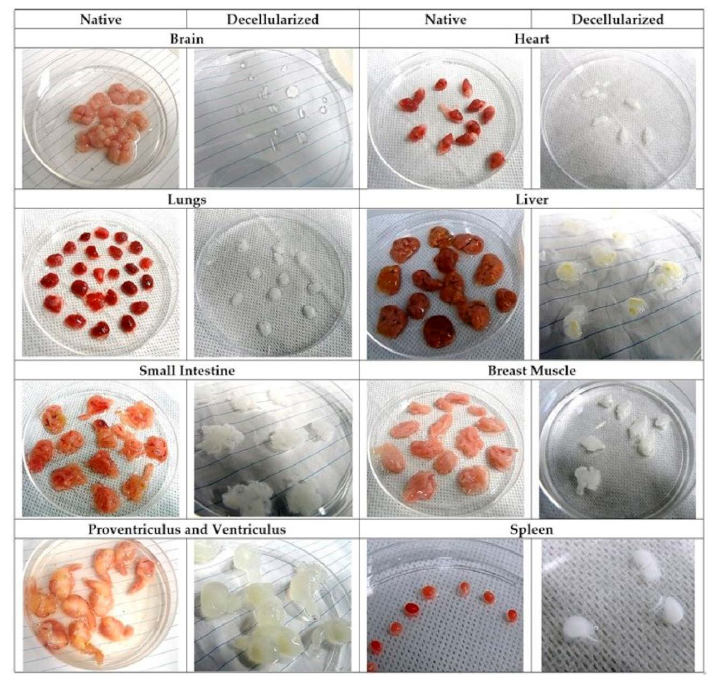
Figure A2. Effect of iWO-DCL on the macroscopic appearance of ED18 CE organs at the beginning and the end of processing. Note loss of natural color, whitening of the tissue, and increase in transparency. Some organs, such as the brain, heart, lungs, liver, and skeletal muscles, also significantly decreased in their volume. The samples of the small intestine and spleen shown in the “Native” columns represent the organs that were processed for DCL for 4 h to exemplify the gradual loss of the red tone starting from the edges of the organs due to the combined effects of diffusion and convection of the detergent that destroys the organ cells. This centripetal pattern of discoloration is commonly observed in the organs undergoing iWO-DCL.